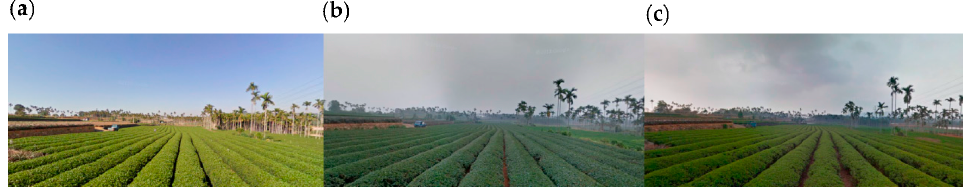
Figure 3. Tea crops ( Camellia sinensis (L.) O. Ktze. Var. Sinensis and Camellia sinensis (L.) O. Ktze. Var.